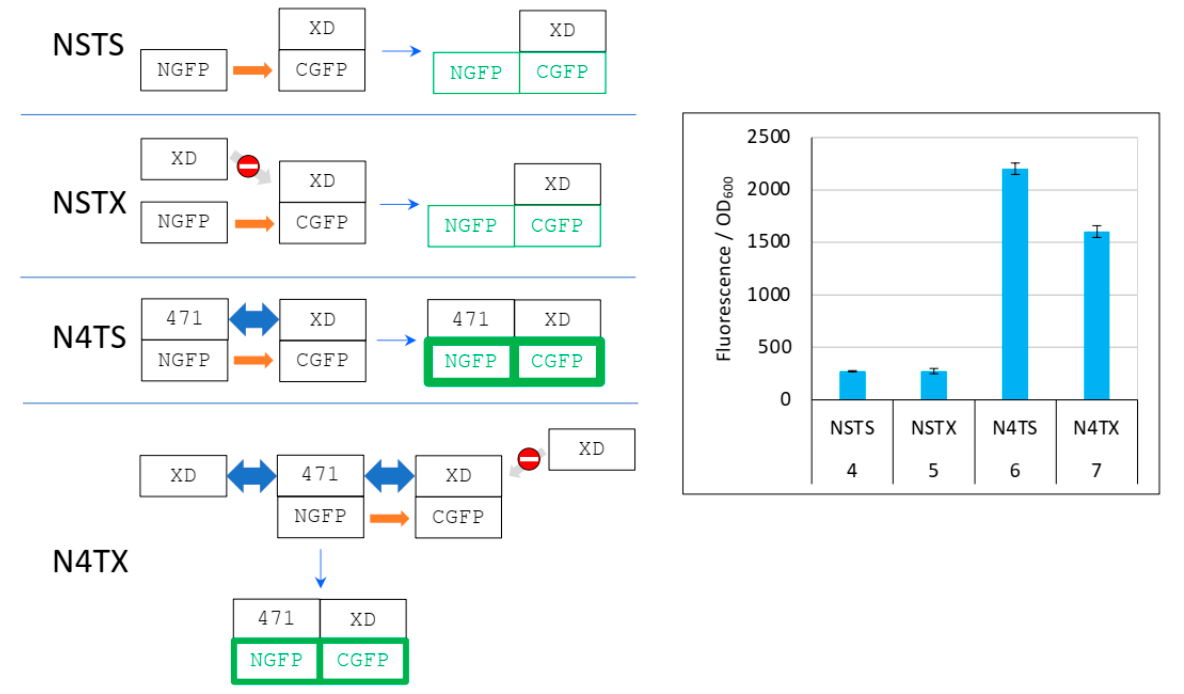
Figure 8. Explanation of Figure 7 results. Left panel, cartoon explaining the different protein interactions and the corresponding fluorescence results. See Figure 6 for details and main text for a description of NSTS, NSTX, N4TS, and N4TX. The light grey arrow with a no-way symbol indicates an absence of interaction. Right panel, fluorescence data of a triplicate experiment run overnight. Numbers 4 to 7 of the x -axis refer to the experimental conditions described in Figure 5.